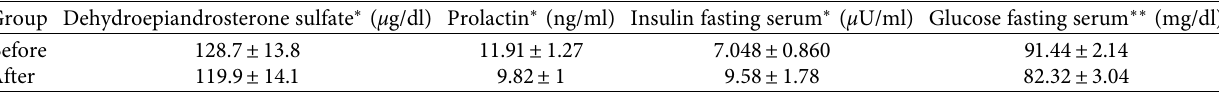
Table 5: The endocrine and metabolic assessment of patients before and after administration of Tracnil ™ . Group Dehydroepiandrosterone sulfate ∗ ( μ g/dl) Prolactin ∗ (ng/ml) Insulin fasting serum ∗ ( μ U/ml) Glucose fasting serum ∗∗ (mg/dl) Before 128.7 ± 13.8 11.91 ± 1.27 7.048 ± 0.860 91.44 ± 2.14 After 119.9 ± 14.1 9.82 ± 1 9.58 ± 1.78 82.32 ±